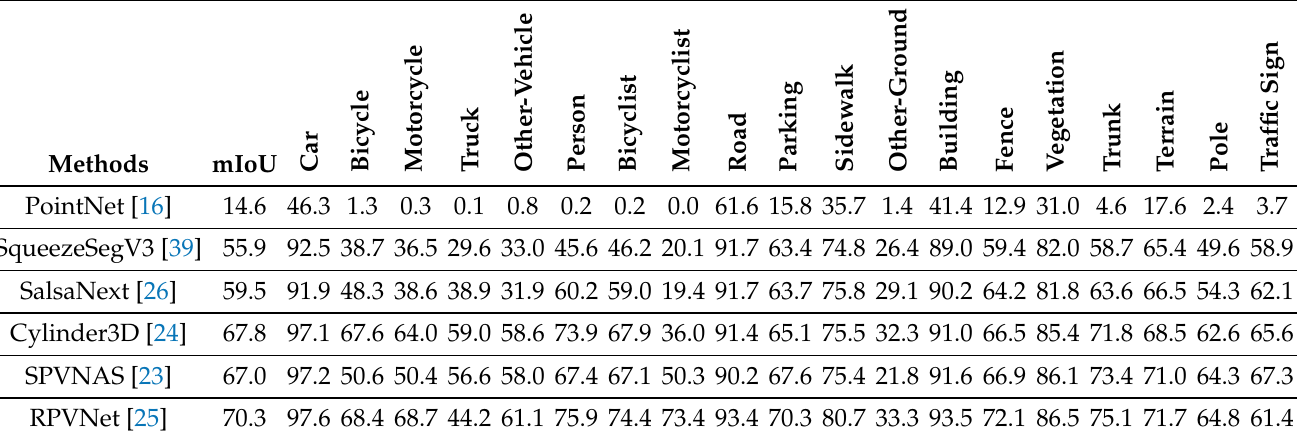
Figure 8. Segmentation of images from ( a ) the KNU dataset (16-channel LiDAR data) and ( b ) the KITTI dataset (64-channel LiDAR data). Table 3. Evaluation of the classification performance of previous